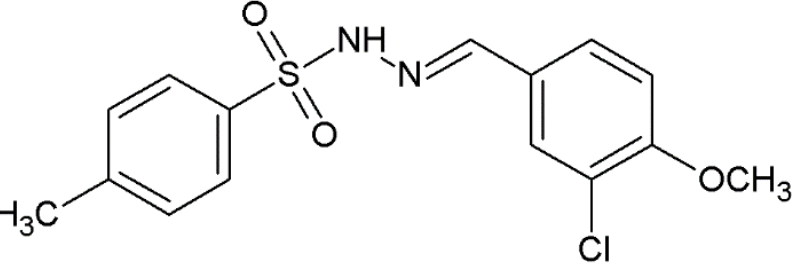
Figure 5. Chemical structure of N -[(3-chloro-4-methoxyphenyl)methylidene]-4-methylbenzenesulphonohydrazide.